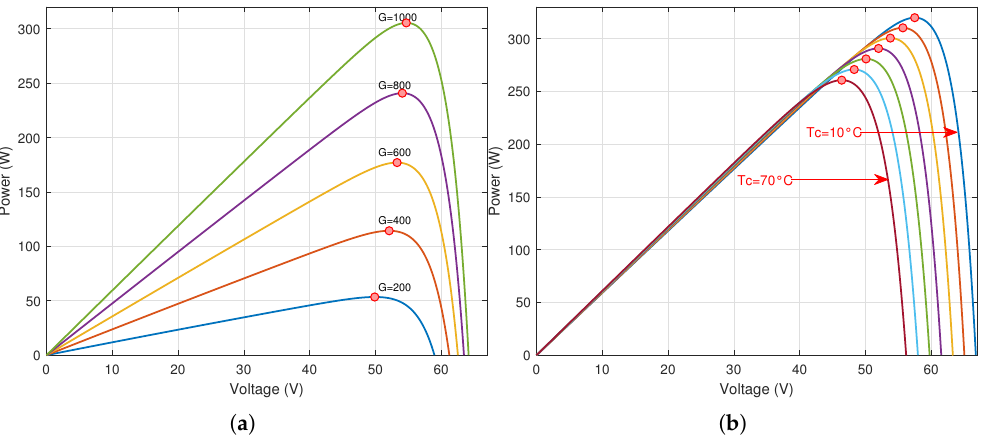
Figure 2. The change of the maximum power point of the PV panel (SUNPOWER 305) for the variation of: ( a ) solar irradiance at T c = 25 ◦ C; ( b ) cell temperature at G = 1000 W/m 2